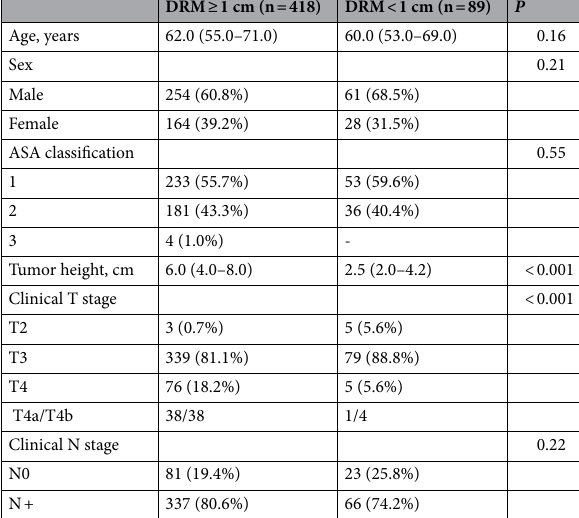
Table 1. Patient characteristics. DRM, distal resection margin. ASA American Society of